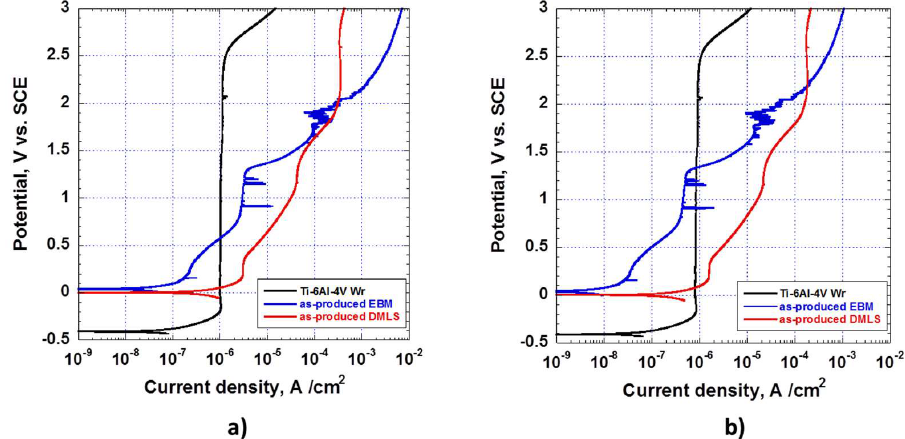
Figure 9. a ) Potentiodynamic polarisation curves obtained by considering the geometrical areas of the as-produced EBM (blue curve) and as-produced DMLS (red curve) specimens, compared to the Ti-6Al-4V Wr specimen (black curve); b ) Potentiodynamic polarisation curves obtained by considering the estimated surface area by means of topographical measurements.